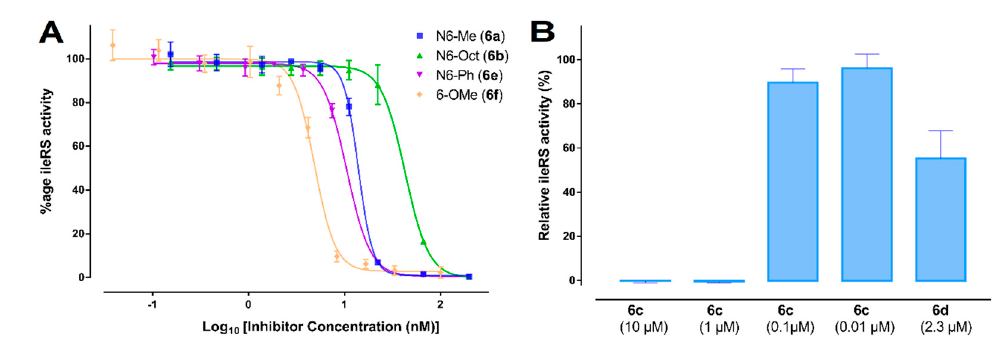
Figure 2. Inhibitory results as obtained via radiolabel aminoacyl transfer assay. ( A ) Dose-response curves of purified E. coli IleRS with the most potent inhibitors on a logarithmic scale. The activity of the enzyme is reported as a percentage value relative to that measured in the absence of inhibitor. The presented fit of the measured points was calculated using the Sigmoidal dose-response (variable slope) [34]. ( B ). Relative inhibitory activity of the dodecyl and octadecyl derivatives at higher concentration against purified E. coli IleRS. The relative activity was determined by comparing to values measured in the absence of an inhibitor and assuming its 100% enzyme activity. Average of three experiments with SD error bar. Table 1. IC 50 of selected ISA analogues substituted with different lipophilic groups. Compound